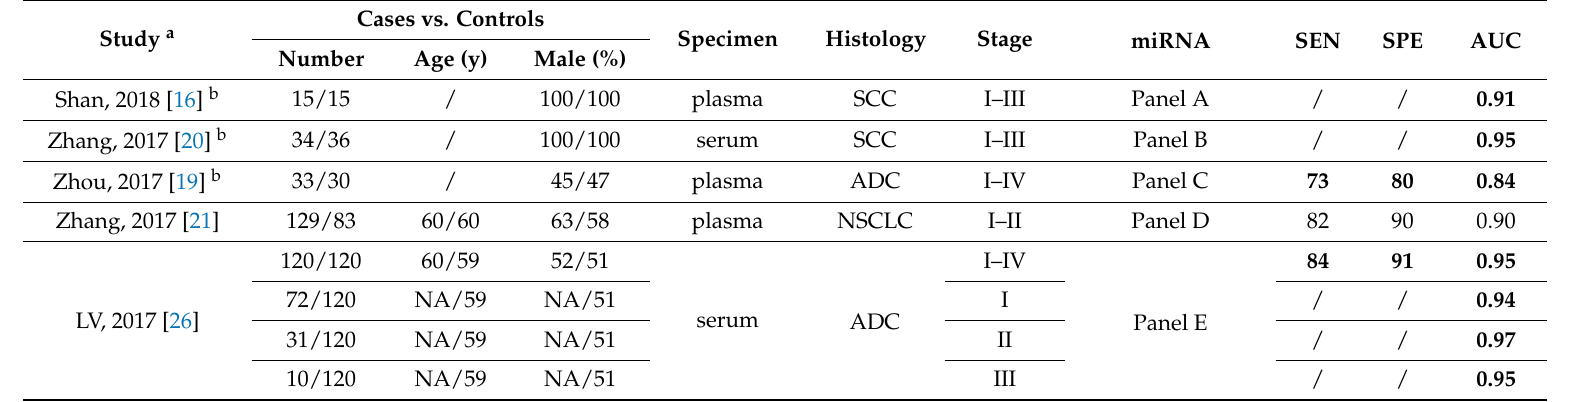
Table 2. Diagnostic performance of miRNA panels in lung cancer in East Asian